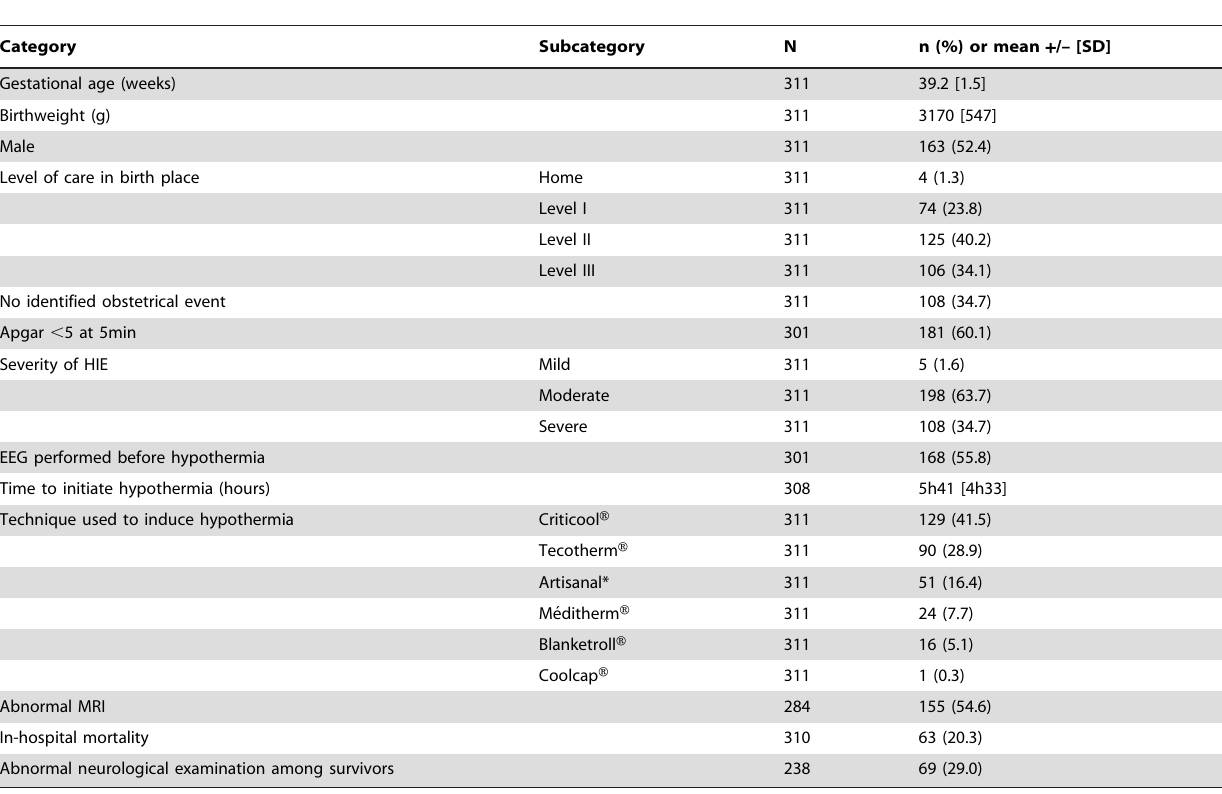
Table 1. General characteristics of the whole study population.